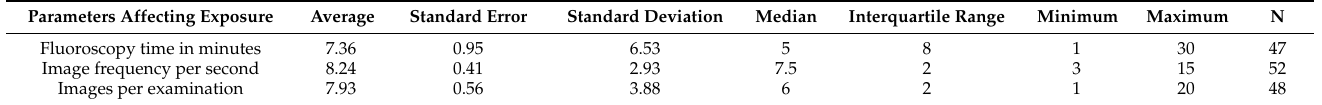
Table 5. Parameters affecting exposure, such as fluoroscopy time, image frequency and images per examination. Parameters Affecting